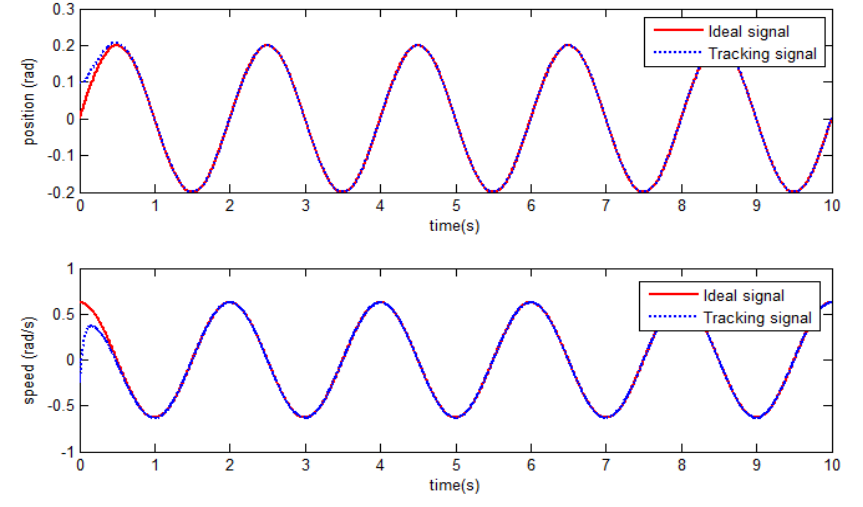
Figure 5. States of the ARA joint 1.